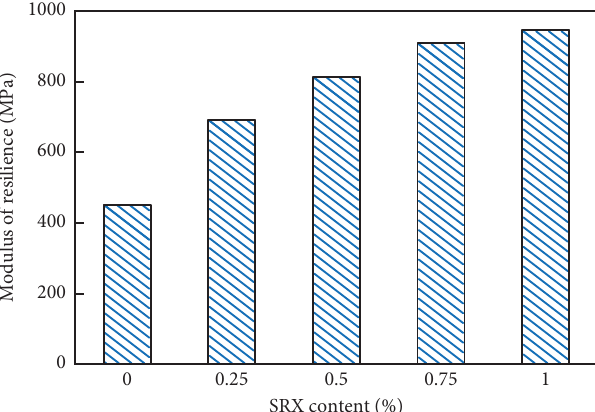
Figure 14: Change law of resilient modulus with SRX content.